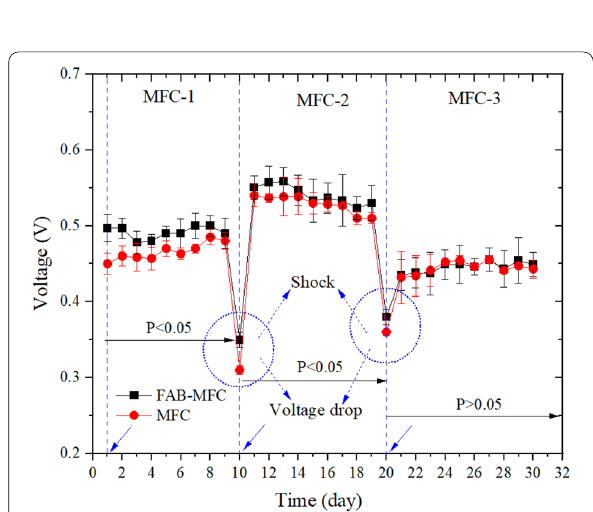
Fig. 7 The voltage generated in the lab-scale anaerobic ‑ MFC integrated domestic wastewater treatment system. Error bars indicate the standard deviation. The p values indicate the significant difference ( p < 0.05) between the FAB–MFC (FAB ) and MFC. External load 1000 + Ω. Shock means the point where the minimum voltage was observed during the transition to the next treatment phase. A circle with arrows indicates wastewater replacement and system